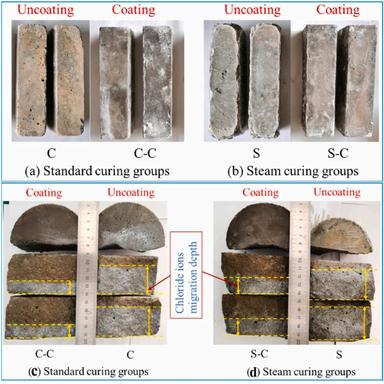
Appearance of the mortars: (a) and (b) after 120 drying-wetting cycles under sulfate attack; (c) and (d) chloride ion migration depth (C: standard curing; C–C: standard curing with a carbonation layer; S: steam curing; S–C: steam curing with a carbonation layer).